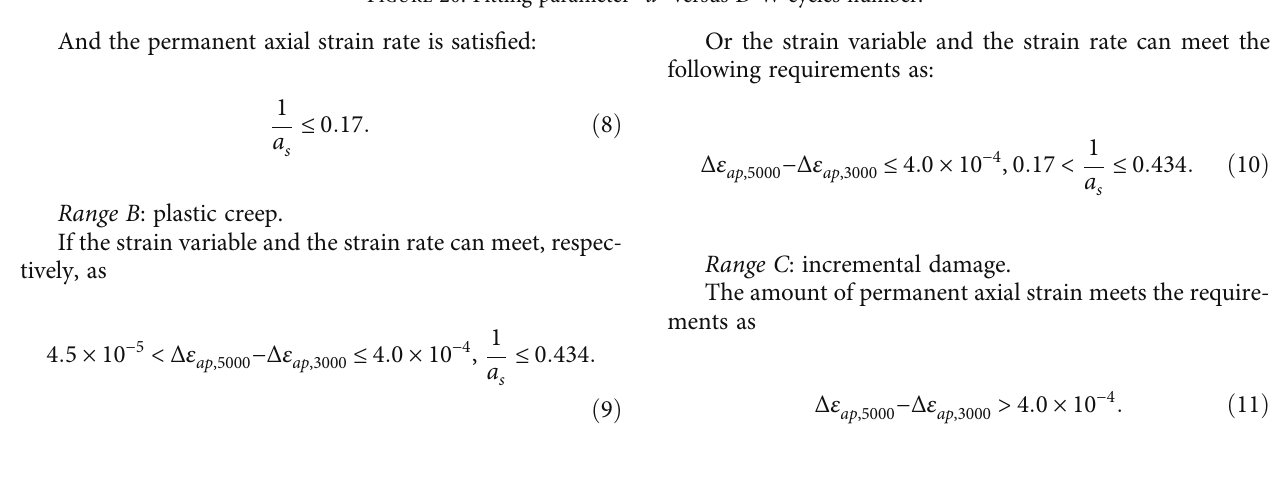
Figure 20: Fitting parameter “ a ” versus D-W cycles